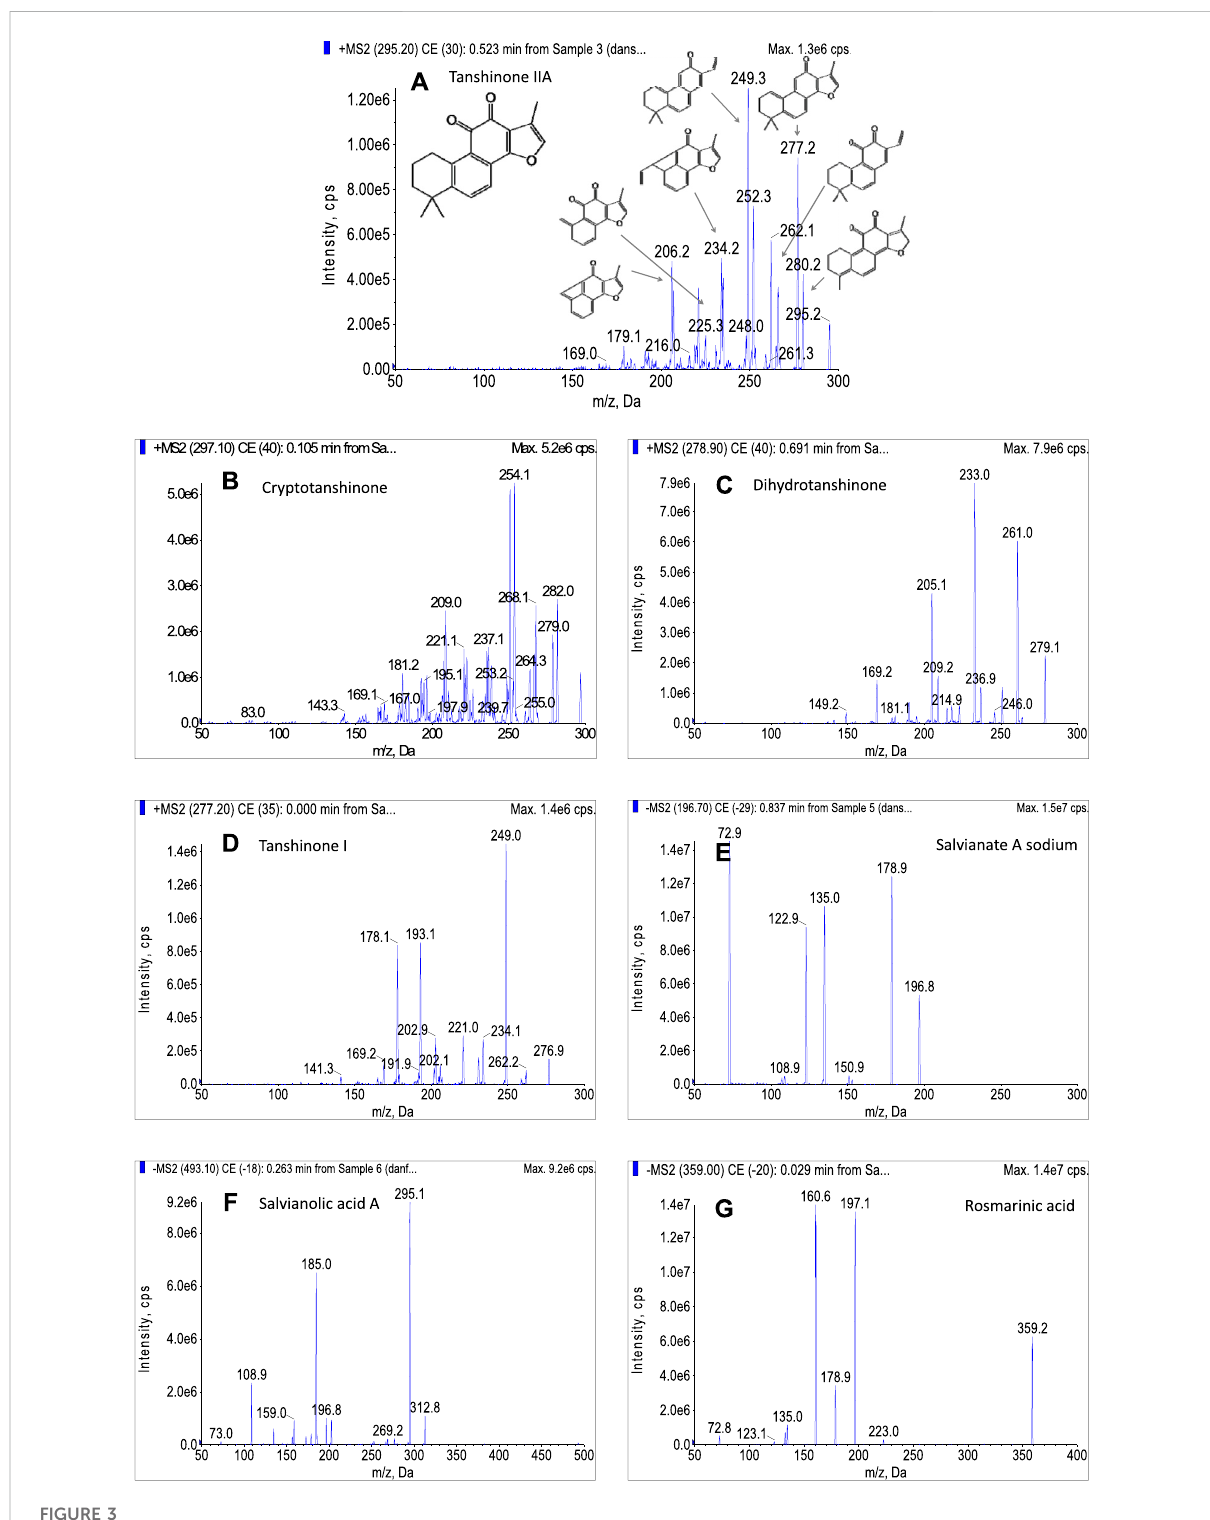
FIGURE 3 The secondary mass spectra of seven bioactive